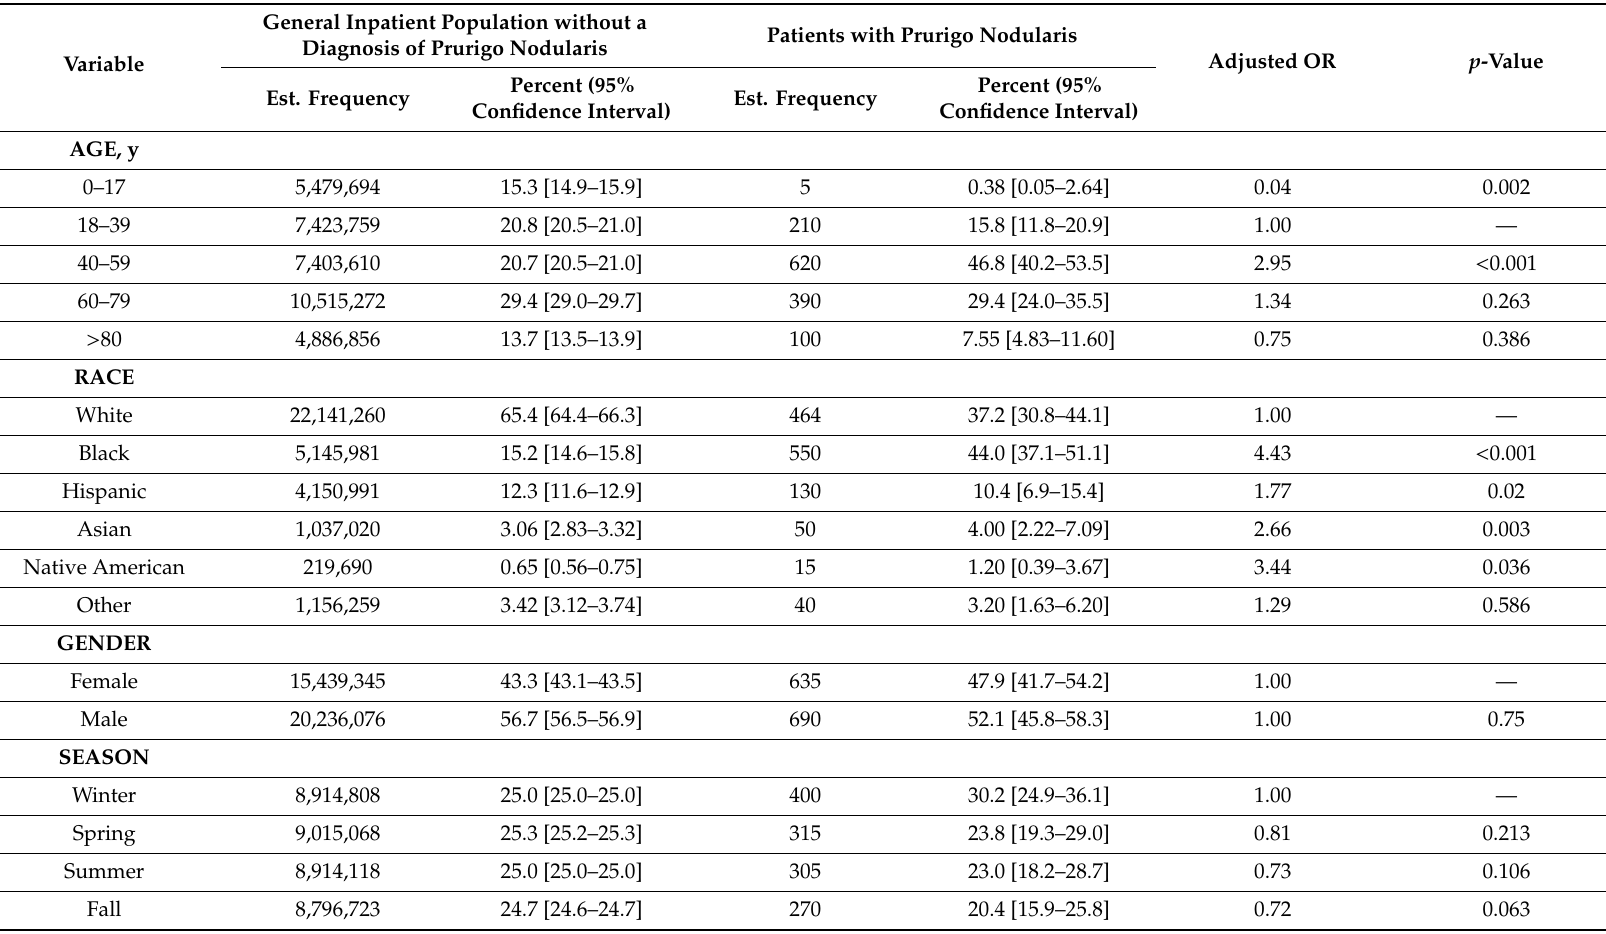
Table 1. Demographics of hospitalized patients with a diagnosis of prurigo nodularis compared to the general inpatient population without a diagnosis of prurigo